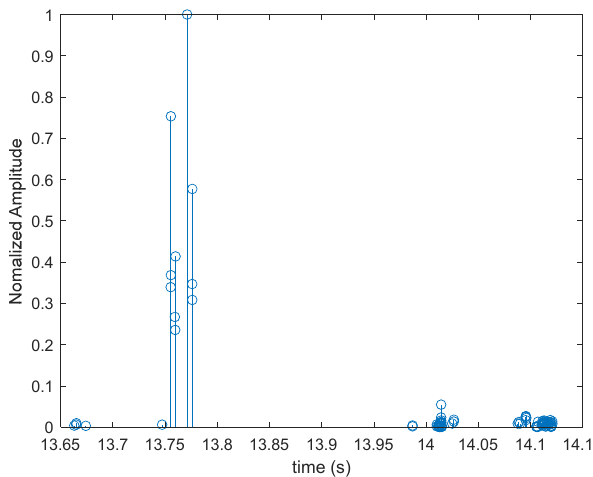
Figure 6. Sound speed profile.